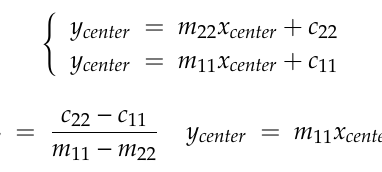
Figure 8. Calculation of the center of the circle.